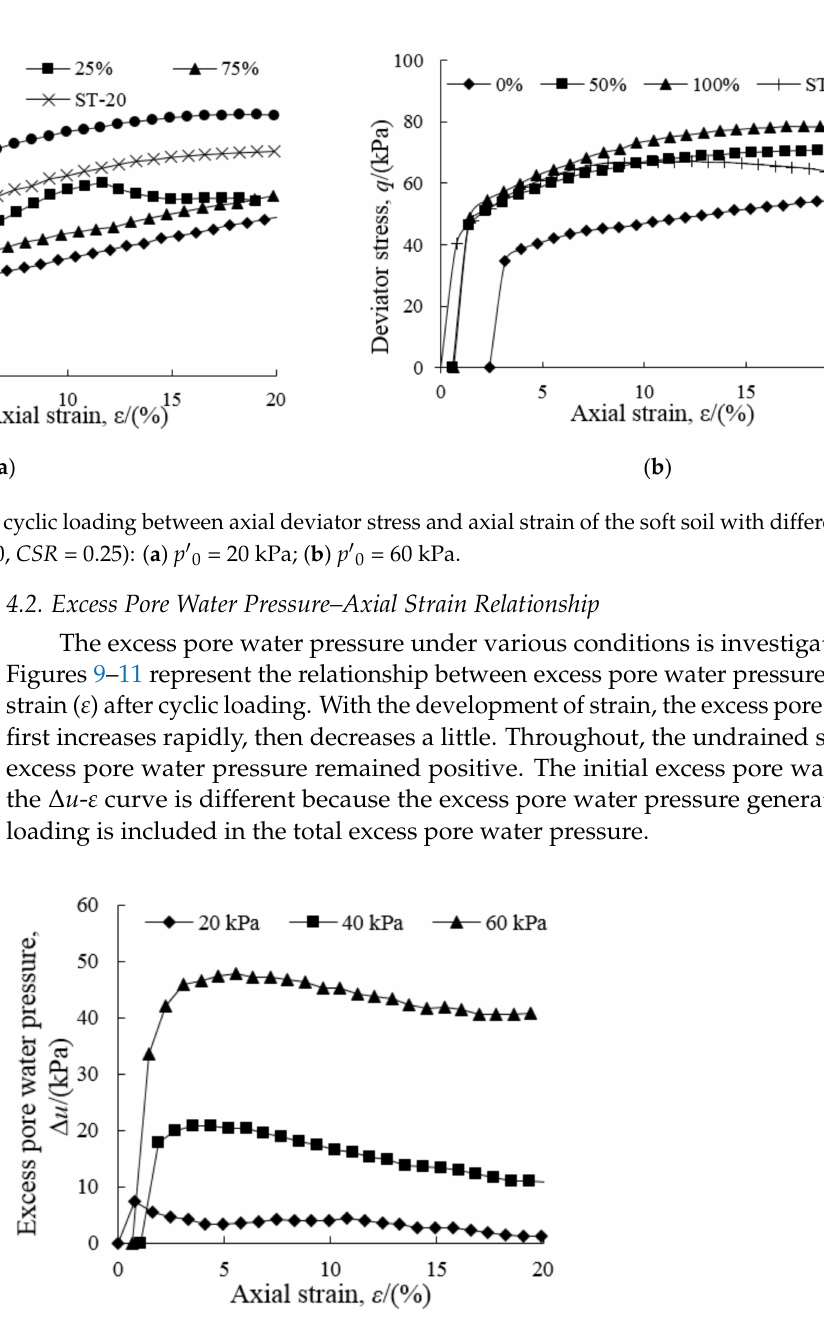
Figure 9. Variations of excess pore water pressure versus axial strain of the soft soil at different confining pressures after cyclic loading ( n = 1000, CSR = 0.25, U r =